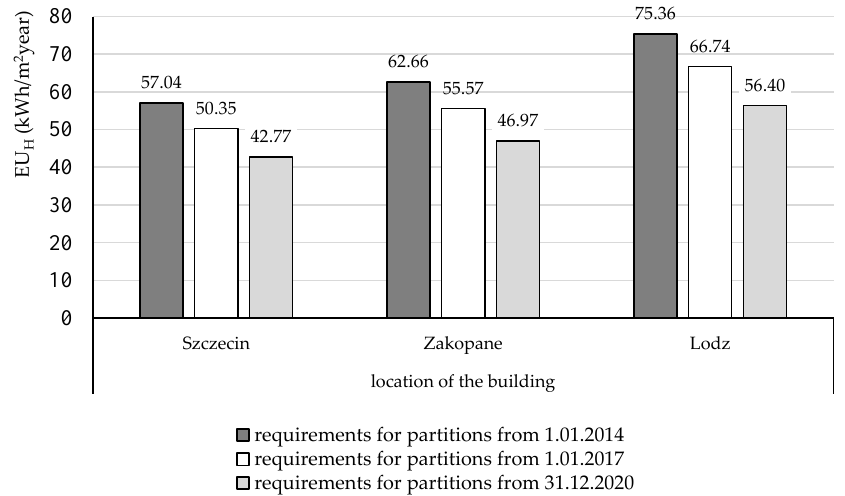
Figure 2. Changes in the index of annual usable energy demand of heating of the building EU H for the considered periods of application of the required U i values and selected groups of climatic conditions (own elaboration).